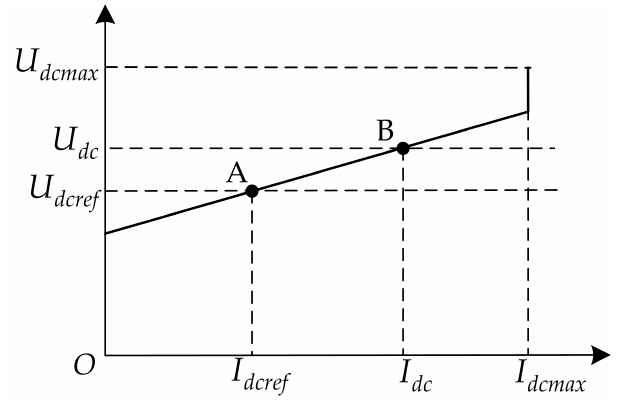
Figure 6. Characteristics of traditional DC voltage droop control.